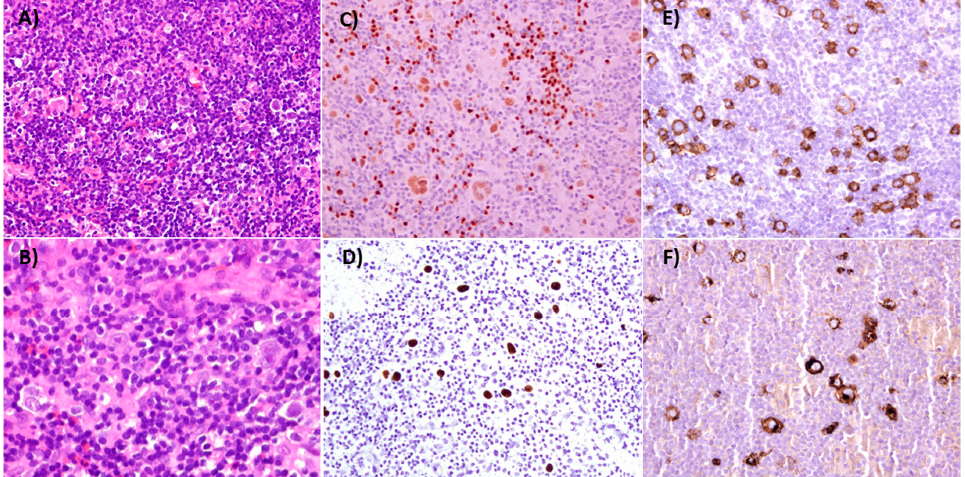
Figure 1. Classical Hodgkin Lymphoma, Mixed Cellularity. The lymph node architecture is effaced by a mixed population of lymphocytes, plasma cells, eosinophils, histiocytes and Reed–Sternberg (RS) cells ( A , B ), Hematoxilin & eosin, 100× and 400×). RS cells are weakly positive for PAX5 ( C ), 200×), and Epstein–Barr encoded RNA (EBERs) can be detected ( D ), 200×). CD30 and CD15 are strongly positive in RS cells (( E , F respectively, 200×).